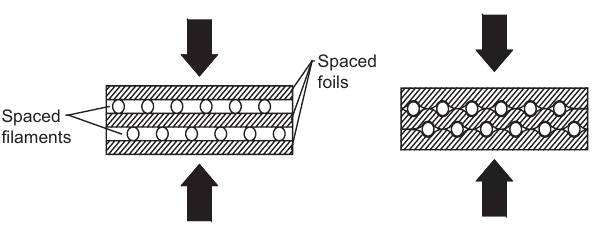
Figure 3 Flow and diffusion bonding of the metal matrix in heated